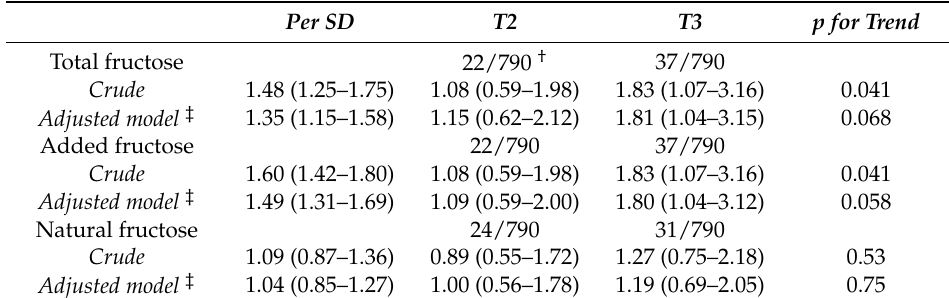
Table 2. The hazard ratio (95% confidence interval) of cardiovascular disease outcomes across tertile categories of dietary